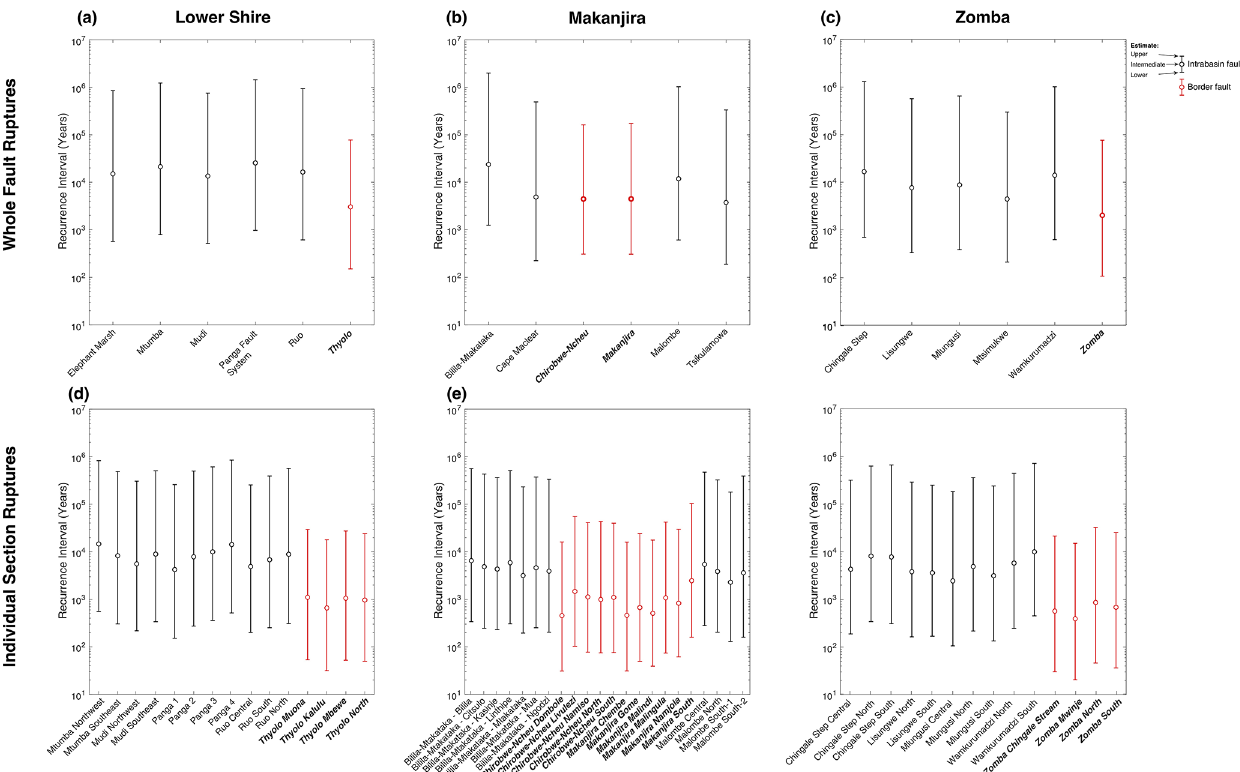
Figure 10. Recurrence interval ( R ) estimates in the SMSSD for (a–c) whole-fault ruptures and (d–f) individual-section ruptures. Note, R estimates for each Panga Fault are included in panel (d) , and a multi-fault rupture is shown in panel (a) .